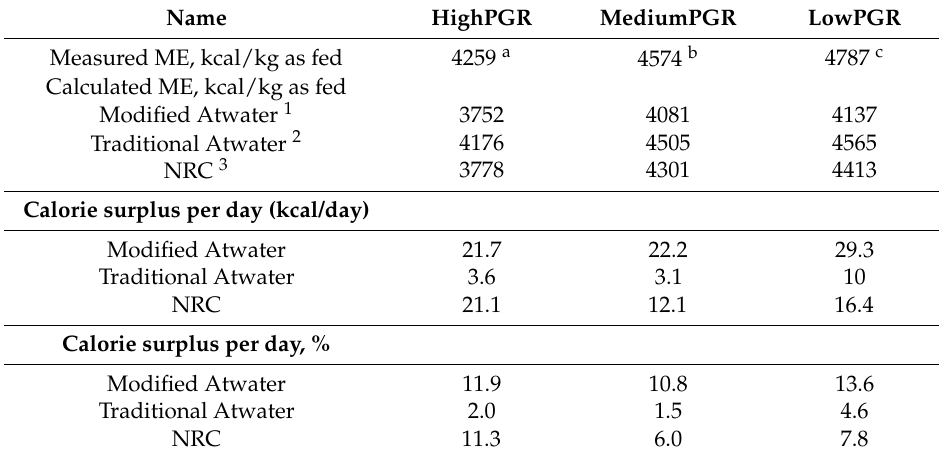
Table 5. Comparison of measured ME with ME calculated using Atwater and modified Atwater equations, and resulting caloric surplus per day for 3 experimental diets differing in perceived glycemic response (PGR) fed to